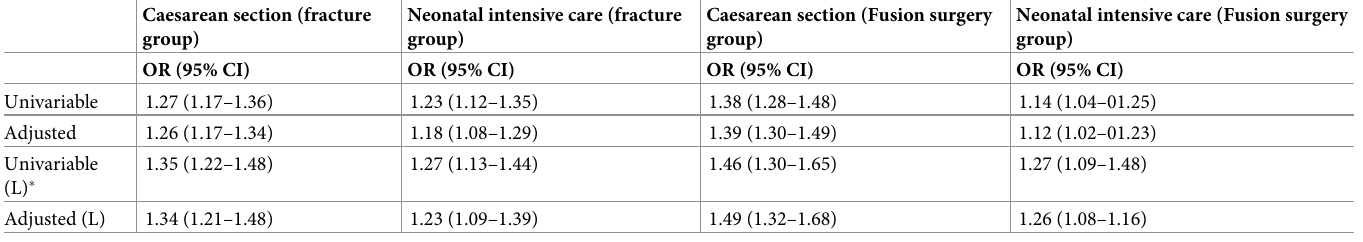
Table 2. Univariable and multivariable logistic regression interpreted as odds ratios (OR) with 95% confidence intervals (CI) for the main variables. Both groups were compared with the control group. Also, patients with fracture or surgery in lumbar spine (L) were compared with control group separately. The models were adjusted by maternal smoking and diabetes during